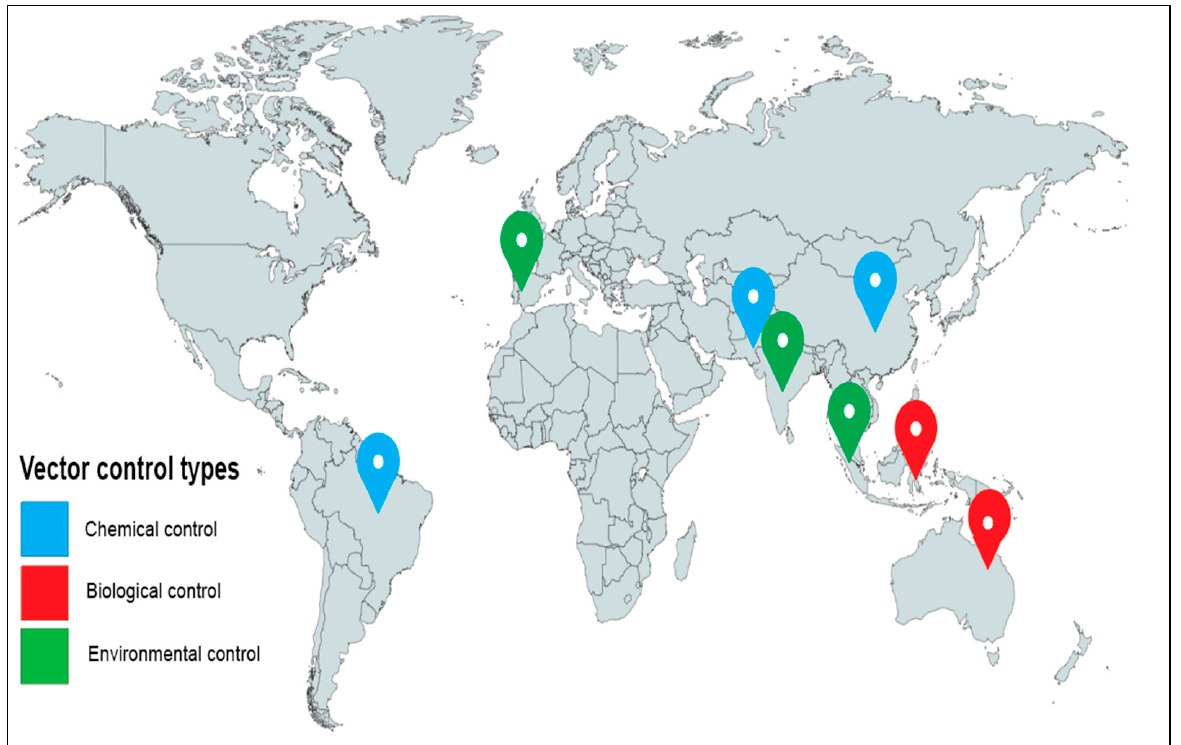
Figure 1. The distribution of the locations of the selected experimental studies used for validating models describing the vector control types.